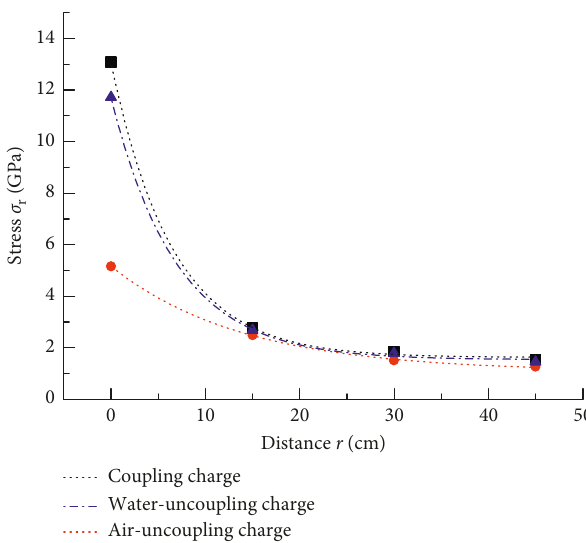
Figure 18: The pressure attenuates in rock with